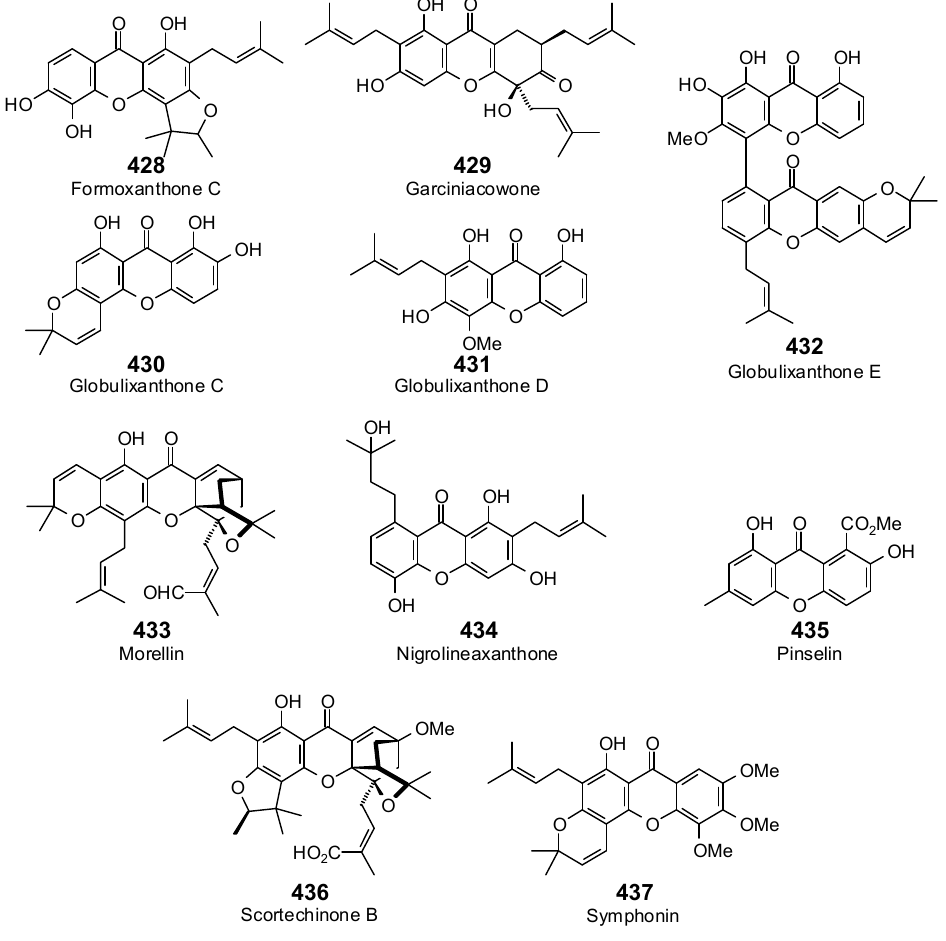
Figure 19. Xanthones examined in this work.